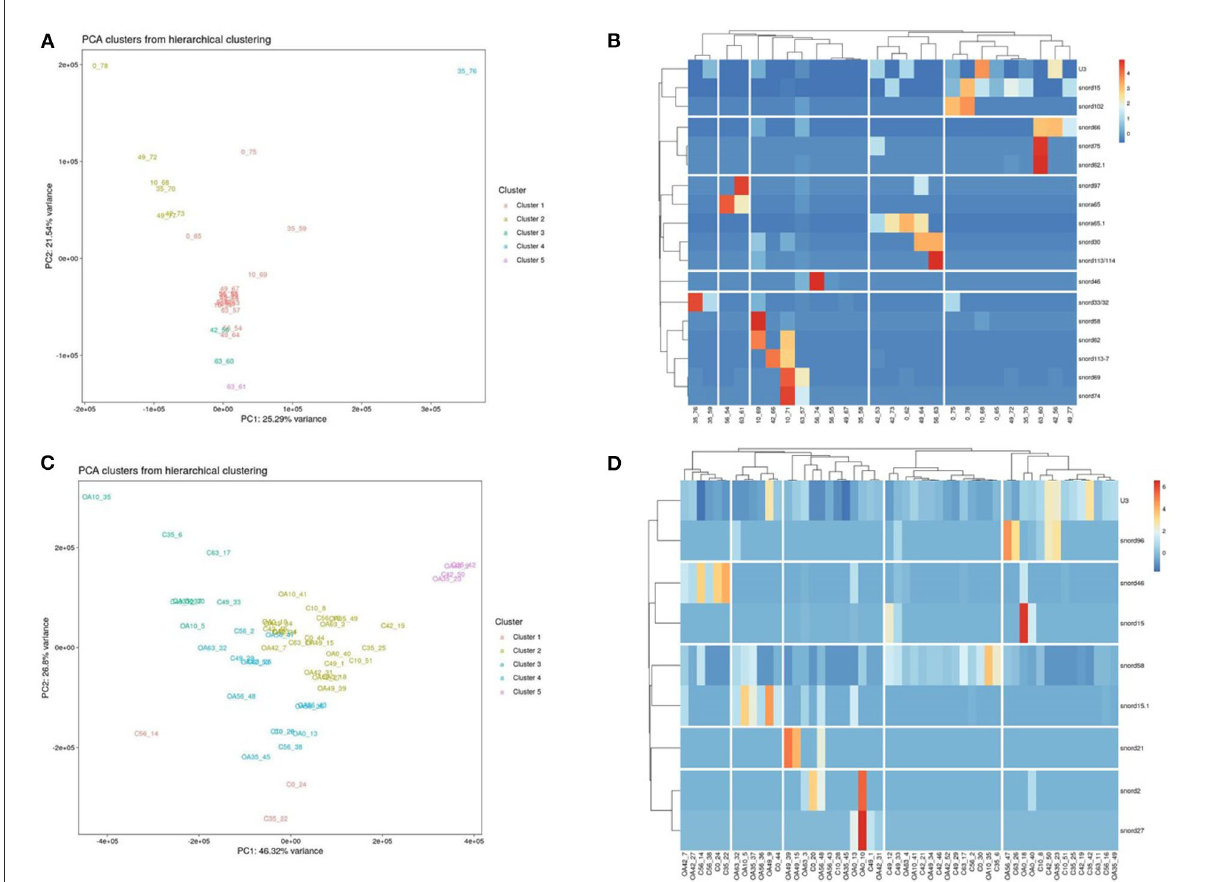
FIGURE8 Differentially expressed (DE) snoRNAs in plasma and synovial fluid-derived EVs. (A) PCA of DE snoRNAs for plasma-derived EVs. (B) Heatmap of DE snoRNAs ( p < 0.05) in plasma-derived EVs. (C) PCA of snoRNAs for synovial fluid-derived EVs (C, control; OA, osteoarthritis). Numbering of samples: the first number is the day of sampling (0, 10, 35, 42, 49, 56, and 63). The second number is the original sample ID, n = 4 horses. (D) Heatmap of DE snoRNAs ( p < 0.05) in synovial fluid-derived EVs. Heatmaps were created using the R pheatmap package. Clustering was conducted with the “average” method and by correlation distancing. Scaling is unit variance scaled expression and based on read counts. Clustering distances are based on Pearson